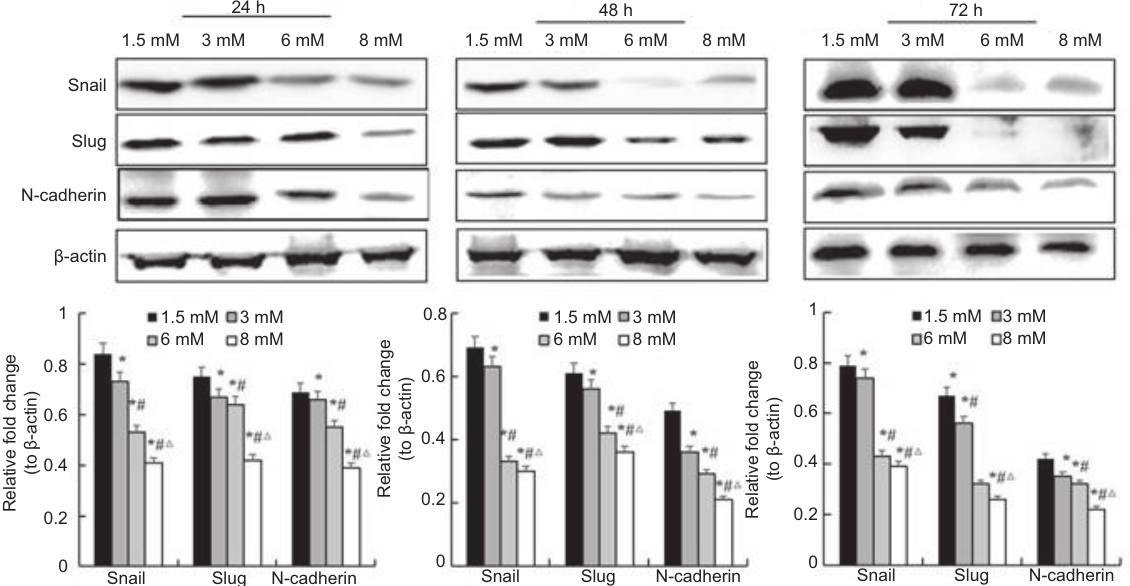
Figure 6: Western blot analysis the protein expression of epithelial-mesenchymal transition marker Snail, Slug and N-cadher in A498